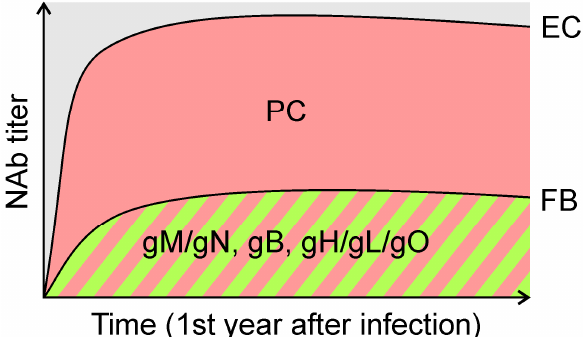
Figure 3. In vitro HCMV NAb responses. During the first year after primary HCMV infection, HCMV+ individuals develop NAb responses with different capacity to prevent in vitro EC and FB infection [56]. NAb measured with EC exceed those measured with FB by orders of magnitude. While FB-specific NAb responses are the result of NAb targeting epitopes of gM/gN, gB, and gH/gL/gO, EC-specific NAb responses are the result of NAb targeting the PC in addition to NAb targeting the gM/gN, gB or gH/gL/gO complexes. The predominant difference in FB- and EC- specific NAb responses is likely a consequence of NAb that target the UL128/130/131A subunits of the PC.